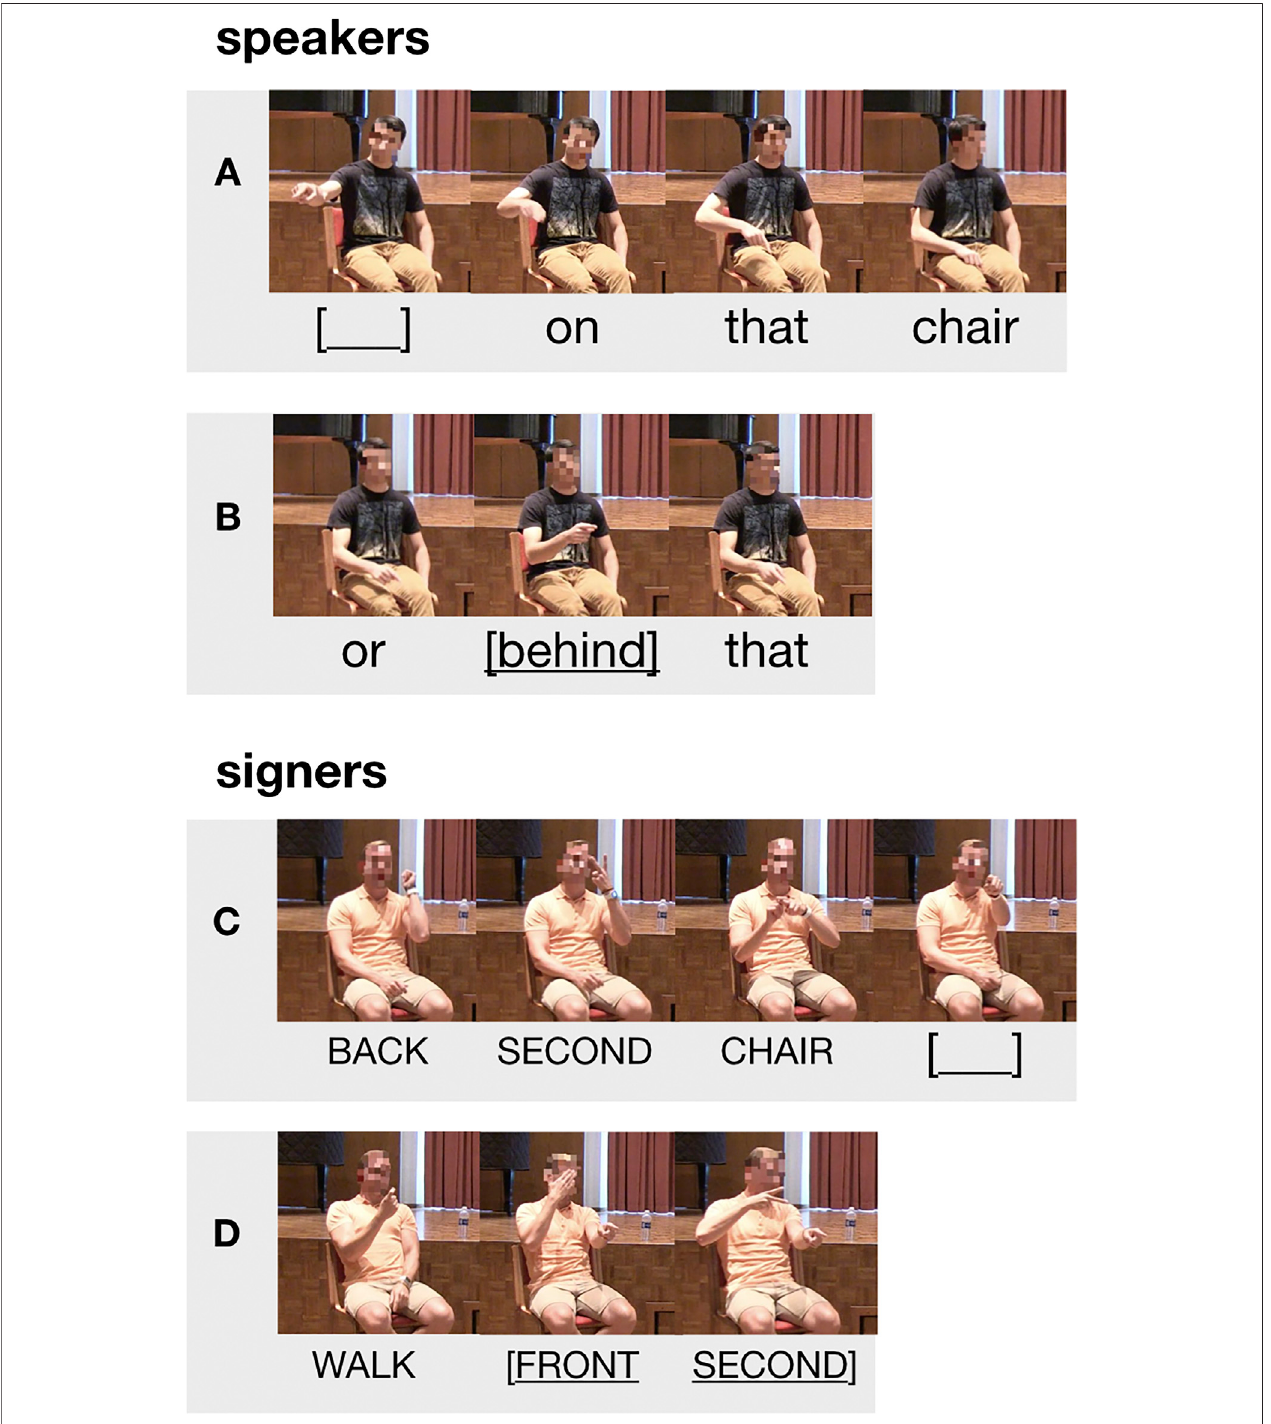
FIGURE 6 | Examples of different structural integration possibilities. Each example consists of an utterance containing a point and three words; each frame shows theparticipantduringproductionoftheword(orstandalonepoint)transcribedbelow.Insomecases,thepointsslottedintothestringofwords,apatternobservedrarely in speakers (A) but very commonly in signers (C) . In other cases, the points spanned across words in the utterance, a pattern observed very commonly in speakers (B) but rarely in signers (D) .